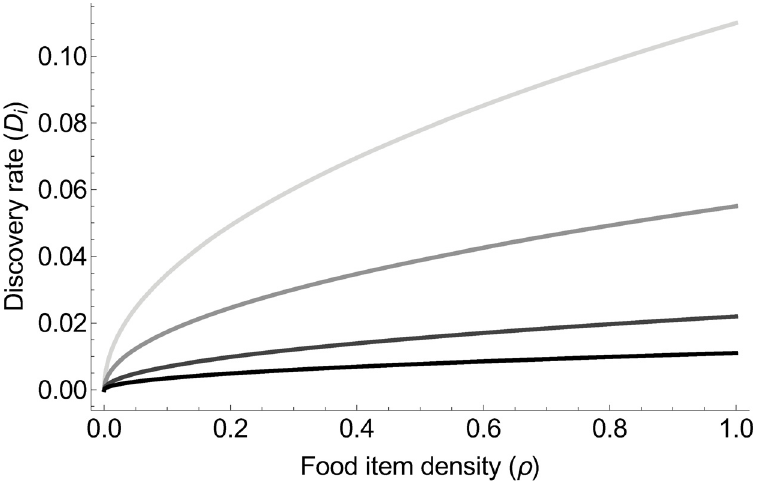
Fig 1. Discovery rate increases with food item density and decreases with the degree of collective foraging x . The different colors represent different degrees of collective foraging: light grey for x = 0, grey for x = 0.5, dark grey x = 0.8, and black for x =